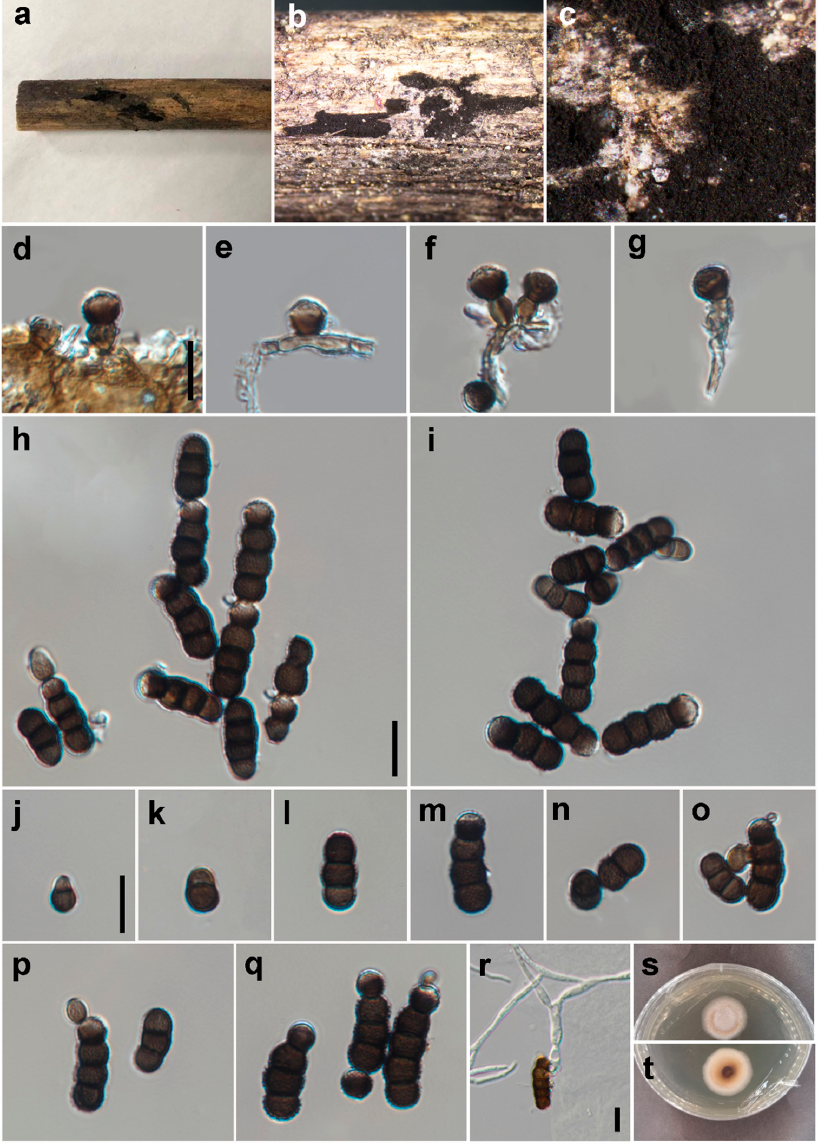
Figure 6. Torula submersa (HKAS 126510, holotype). ( a – c ) Colonies on the natural substrate; ( d – g ) Conidiophores with conidiogenous cells. ( h , i ) Branched chains of conidia. ( j – q ) Conidia. ( r ) Germinated conidium. ( s , t ) Culture on PDA from the surface and reverse. Scale bars: ( d – r ) = 10 µm. Scale bar of d applies to d – g . Scale bar of h applies to h and i . Scale bar of j applies to j – q .